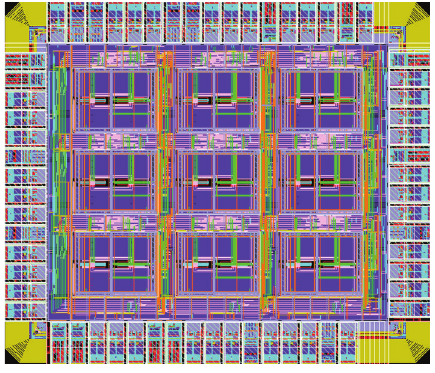
Figure 1: Asynchronous FPGA layout.